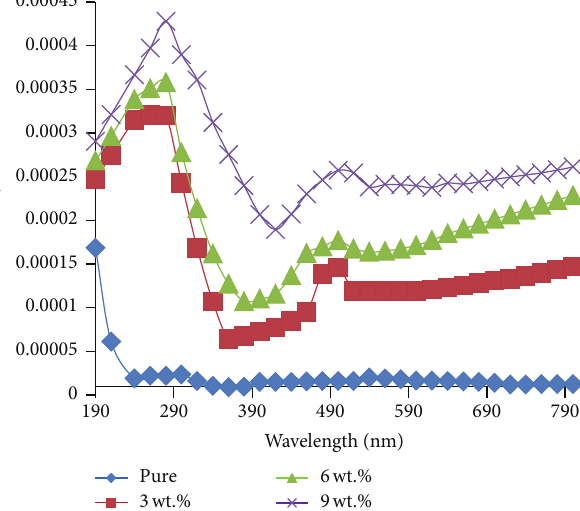
Figure 11: Extinction coefficient of PVAc/0, PVAc/3, PVAc/6, and PVAc/9 wt.% of [Co(NH 3 ) 5 Cl]Cl 2 composites versus